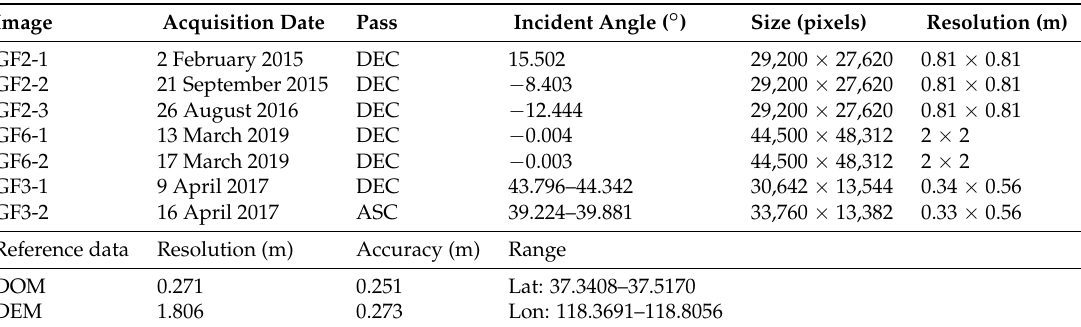
Table 4. Description of experimental data for combined